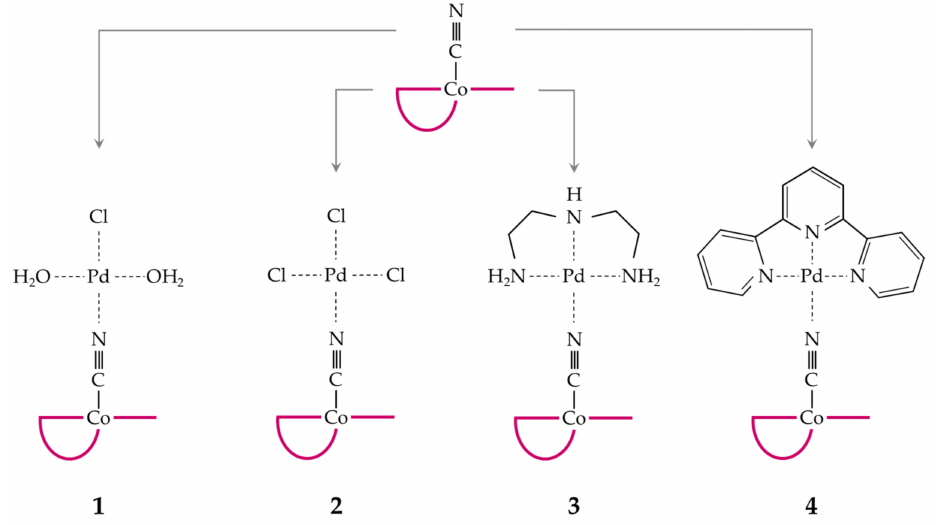
Figure 1. CblCN conjugates with Pd(II).